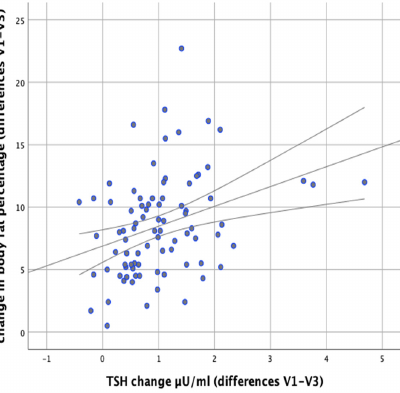
Figure 6. Correlations between changes in body fat content and differences in serum TSH levels (between initial visit V1 and final visit V3).